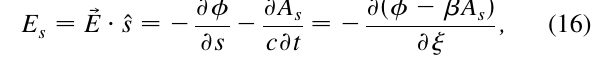
FIG. 6. On-axis radiation wakefield E rad